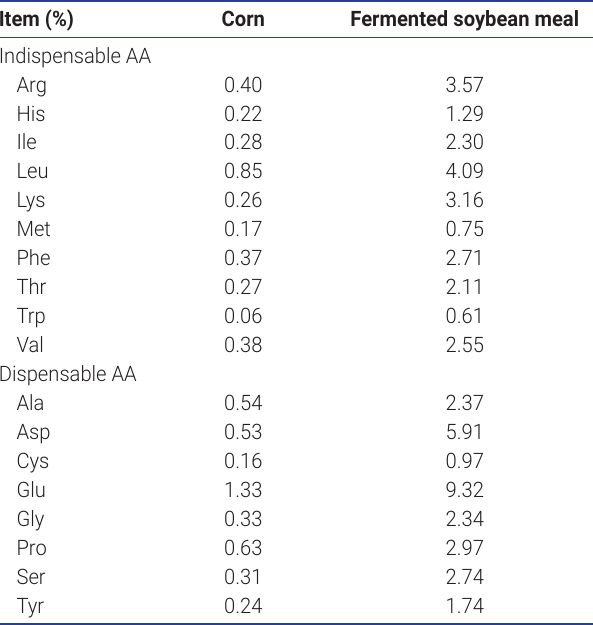
Table 3. Analyzed composition of test ingredients (as-fed basis)